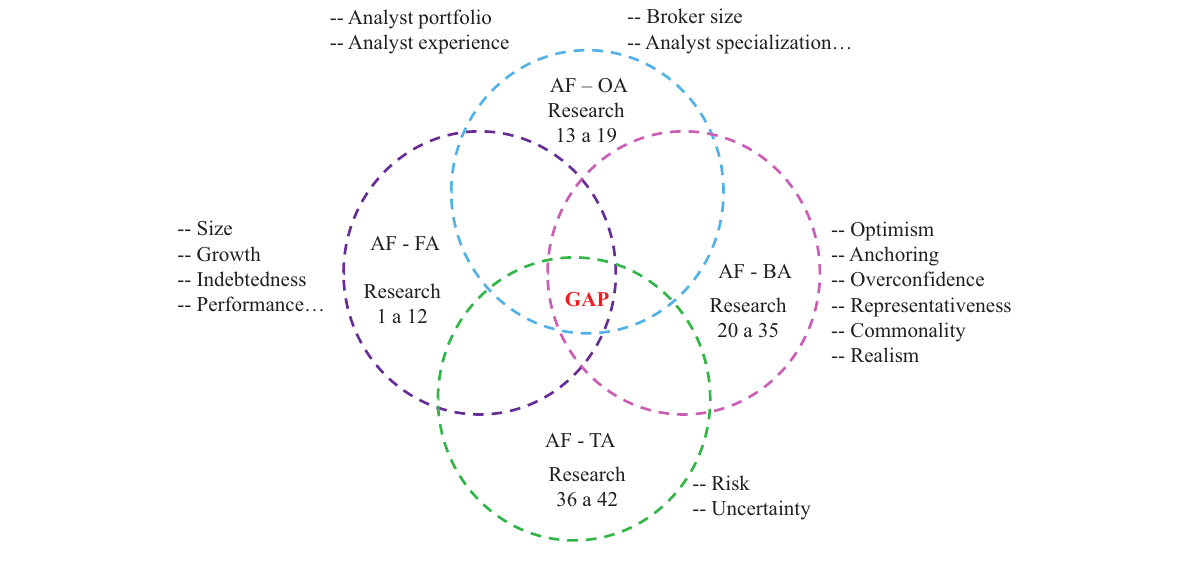
FIGURE 1 | Research intersection. AF, analyst forecast; OA, others aspects; AF, financial aspects; BA, behavioral aspects; TA, temporal